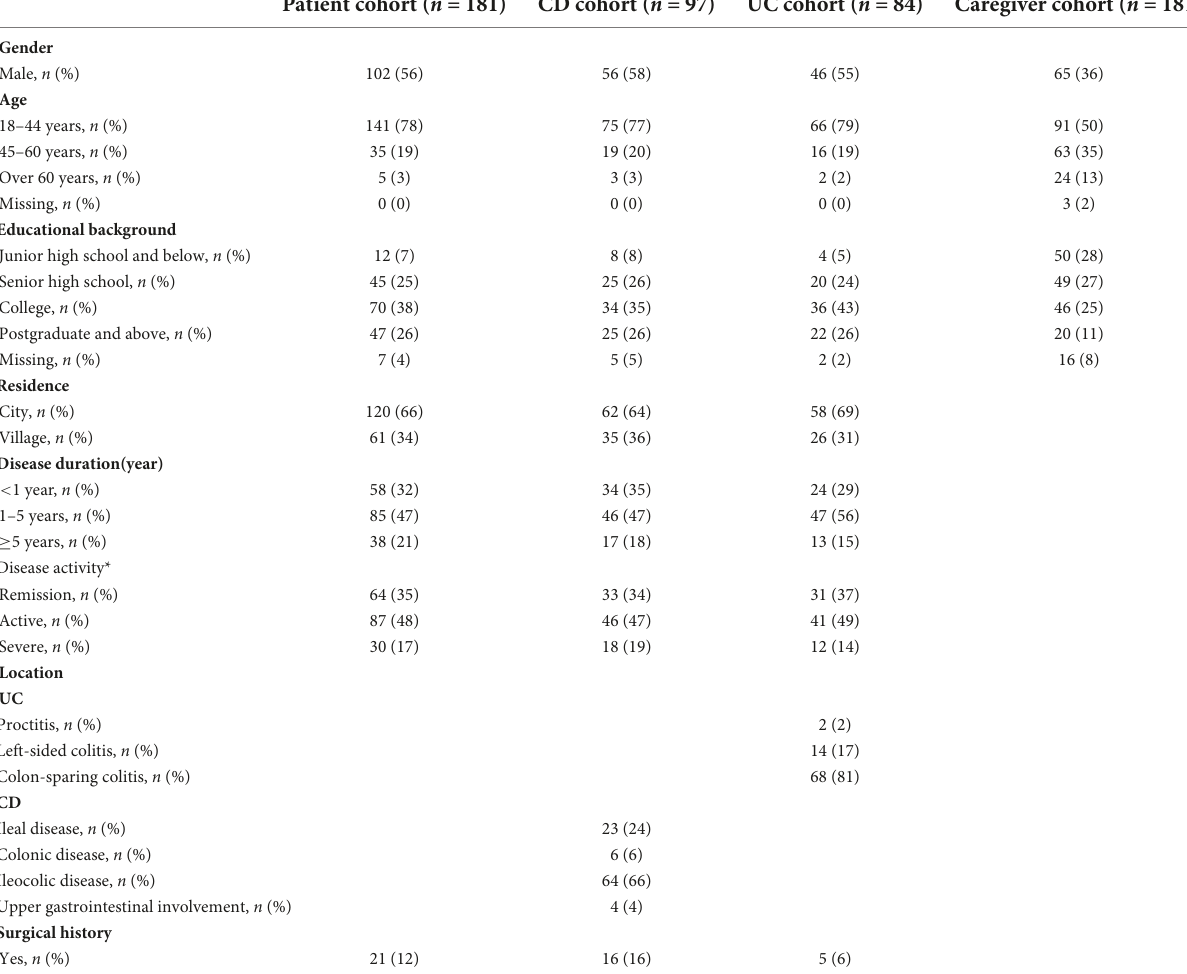
TABLE 1 Demographic and clinical characteristics of patients with inflammatory bowel disease (IBD) and their caregivers. Patient cohort ( n =